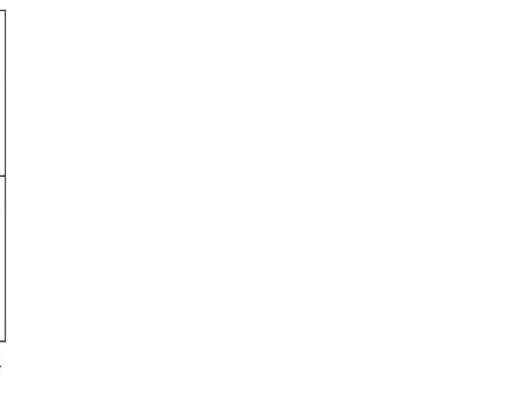
9 of 13 Figure 5. ( a ) Production rates on Pd/Ga 2 O 3 with different light intensities [32], copyright 2011, Else- vier. ( b ) Photocatalytic reaction conversion and selectivity of Pt/Ga 2 O 3 [46], copyright 2021, Ameri- can Chemical Society. ( c ) C 2 H 6 yield over TiO 2 catalysts supported by different noble metals in NOCM [53], and ( d ) IR spectra over Au/TiO 2 and P25 [53]. Copyright 2020, Royal Society of Chem- istry. Generally, photogenerated holes used to activate CH 4 are mainly concentrated at the lattice oxygen sites of metal oxide semiconductors, which makes CH 4 prone to overoxida- tion by lattice oxygen atoms to produce CO, CO 2 , and other by-products. Xiong et al. [54] proposed the single-atom coordination method to regulate the valence band electronic